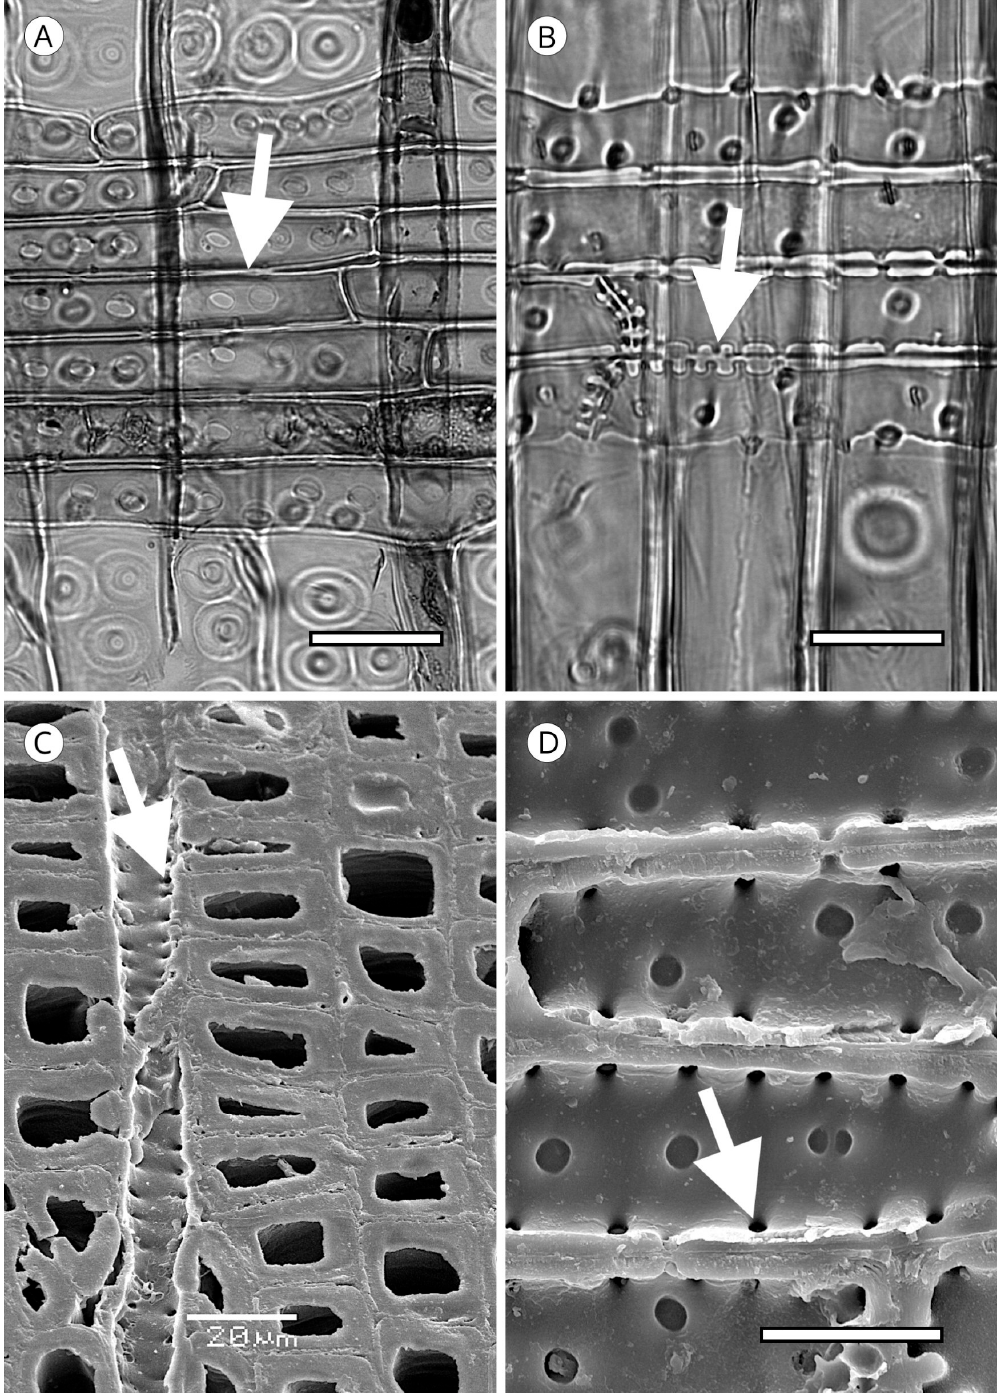
Figure 32. Horizontal walls of ray parenchyma cells. ( A ) Smooth in Taxodium distichum (L.) Rich.; ( B ) Pitted in Abies procera Rehder; ( C ) Pitted in Abies veitchii Lindl. (SEM); ( D ) Pitted in Abies cilicica (Antoine & Kotschy) Carrière (SEM). Scale bars. ( A , B ) = 50 μ m; ( D ) = 25 μ m.